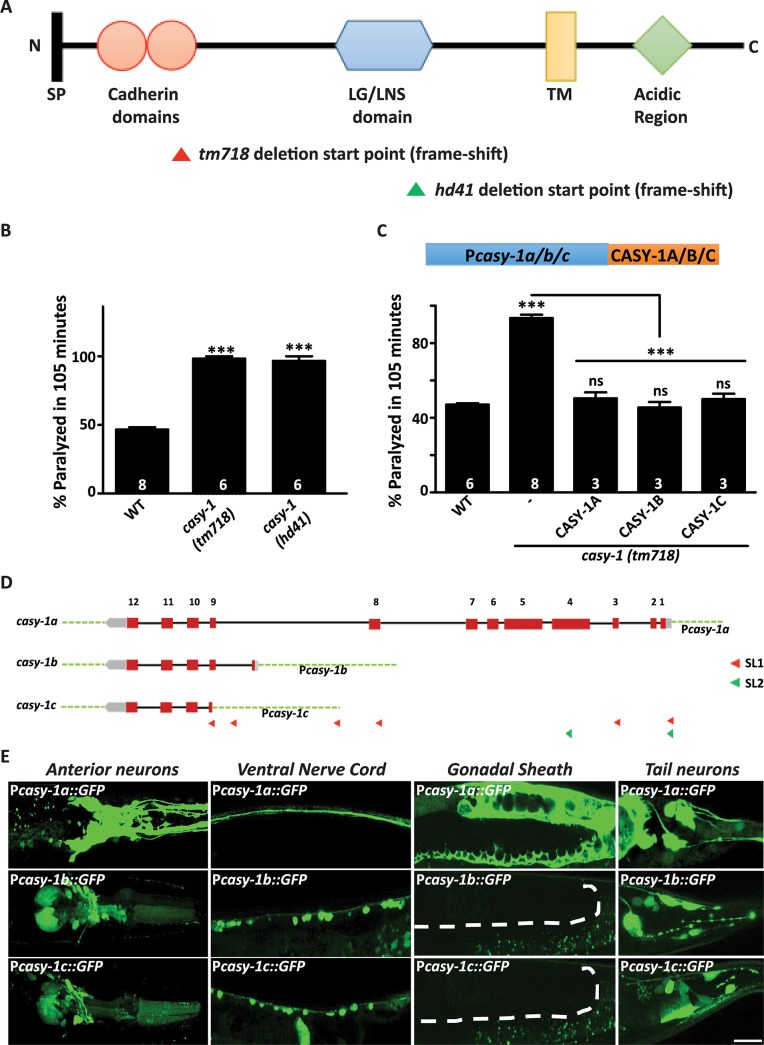
Mutants in casy-1 are hypersensitive to Aldicarb.(A) A schematic representation of the CASY-1 protein showing the N-terminal signal peptide (SP), two-tandem cadherin repeats, LG/LNS domain, transmembrane region (TM) and cytosolic acidic region. The domains deleted in casy-1 mutants are indicated as triangles. The tm718 and hd41 alleles are putative null alleles as deletion starts in the N-terminal region and results in a frame-shift in both cases. (B) Aldicarb-induced paralysis in casy-1 mutants was compared to wild-type (WT) animals. Both casy-1 mutant alleles (tm718 and hd41) are hypersensitive in the Aldicarb assays. Assays were done at least 6 times. (C) A schematic representing the transgenes used in the experiment. Expression of casy-1 isoforms under their endogenous promoters completely rescues the Aldicarb hypersensitivity of casy-1 mutant animals. In B and C, number of assays (~20 C. elegans/assay) is indicated for each genotype. Data are represented as mean ± S.E.M. (***p<0.0001 using one-way ANOVA and Bonferroni's Multiple Comparison Test) “ns” indicates not significant in all Figures. (D) Pictorial representation of the genomic locus of three isoforms. CASY-1B and CASY-1C are expressed by alternative promoters that exist in between the 8th and 9th intron of CASY-1A isoform, which is unusually long (~ 4000bp) and carries their own SL1 leader sequences. The location of promoter sequences utilized in the study are indicated. (E) Representative confocal images of transcriptional reporters of the three casy-1 isoforms. Expression of GFP under isoform-specific promoters showed expression of casy-1a in most of the head neurons including amphid sensory neurons, in VNC, some tail neurons, in the intestine as well as in the gonadal sheath. casy-1b and casy-1c also showed expression in some head neurons, in the ventral cord motor neurons and some tail neurons but no expression in the gonadal sheath. Dotted lines indicate the position of gonadal sheath. Scale bar, 20μm.